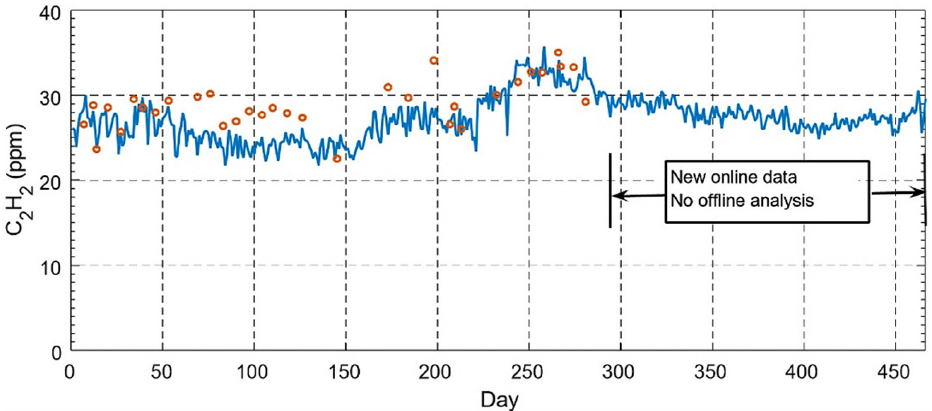
Figure 31. Evolution of acetylene concentration (C 2 H 2 ) over time, online (blue) and offline (orange) data.